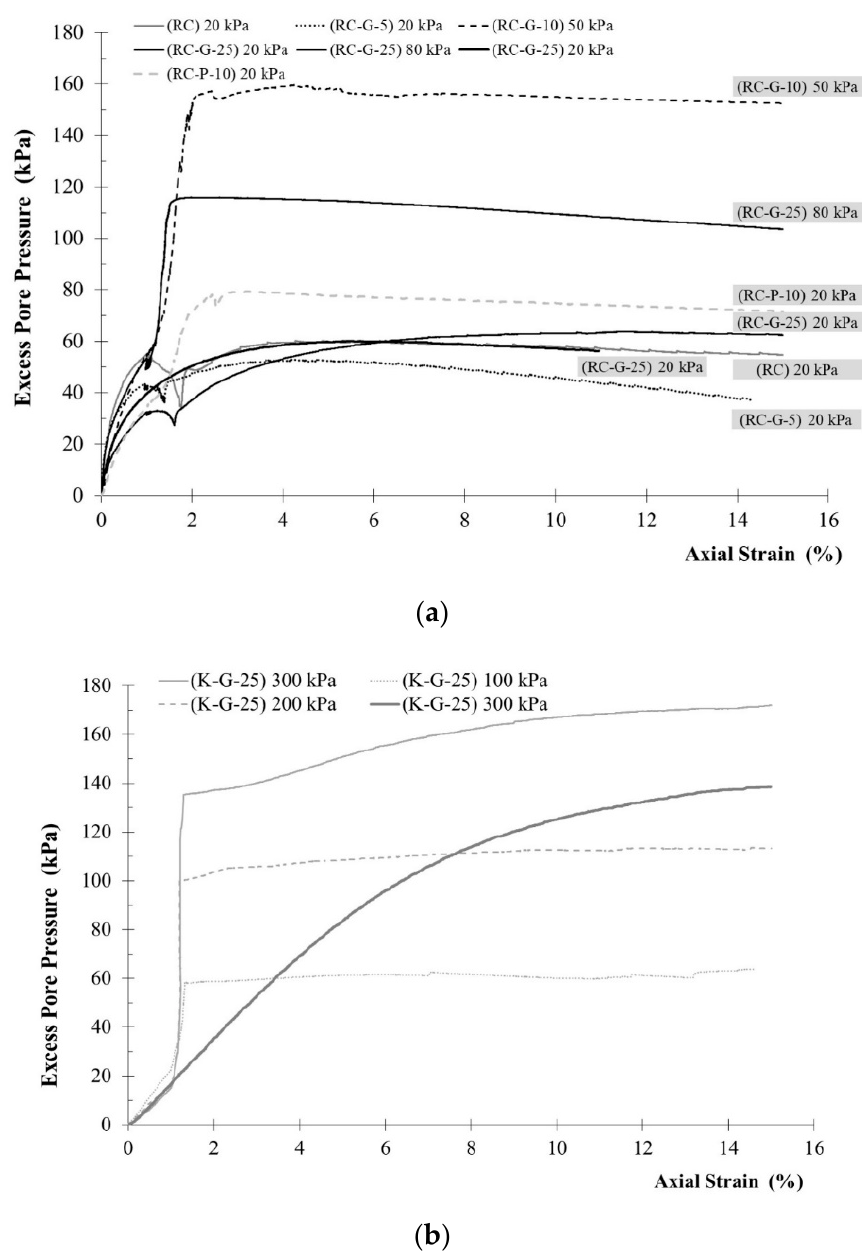
Figure 6. Pore pressure u versus axial strain ε 1 for: ( a ) selected (RC-R) mixtures; ( b ) (K-R) mixtures. Figure 9. Pore pressure u versus axial strain ε 1 for: ( a ) selected (RC-R) mixtures; ( b ) (K-R) mixtures. Figures 4 and 9 present these results on semi-logarithmic scales while Figures 5 and 8 show a linear scale. Due to the high cycle numbers and obvious higher changes in axial strains and pore pressures during the first ten cycles, Figures 8a and 5a show the data for those fragments on a larger